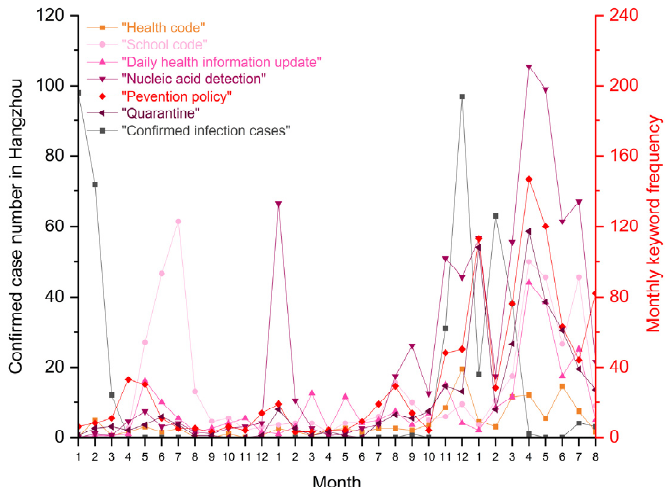
Figure 6. Monthly keyword frequency: “Health code”, “School code”, “Daily health information update”, “Nucleic acid detection”, “Prevention policy”, and “Quarantine”.